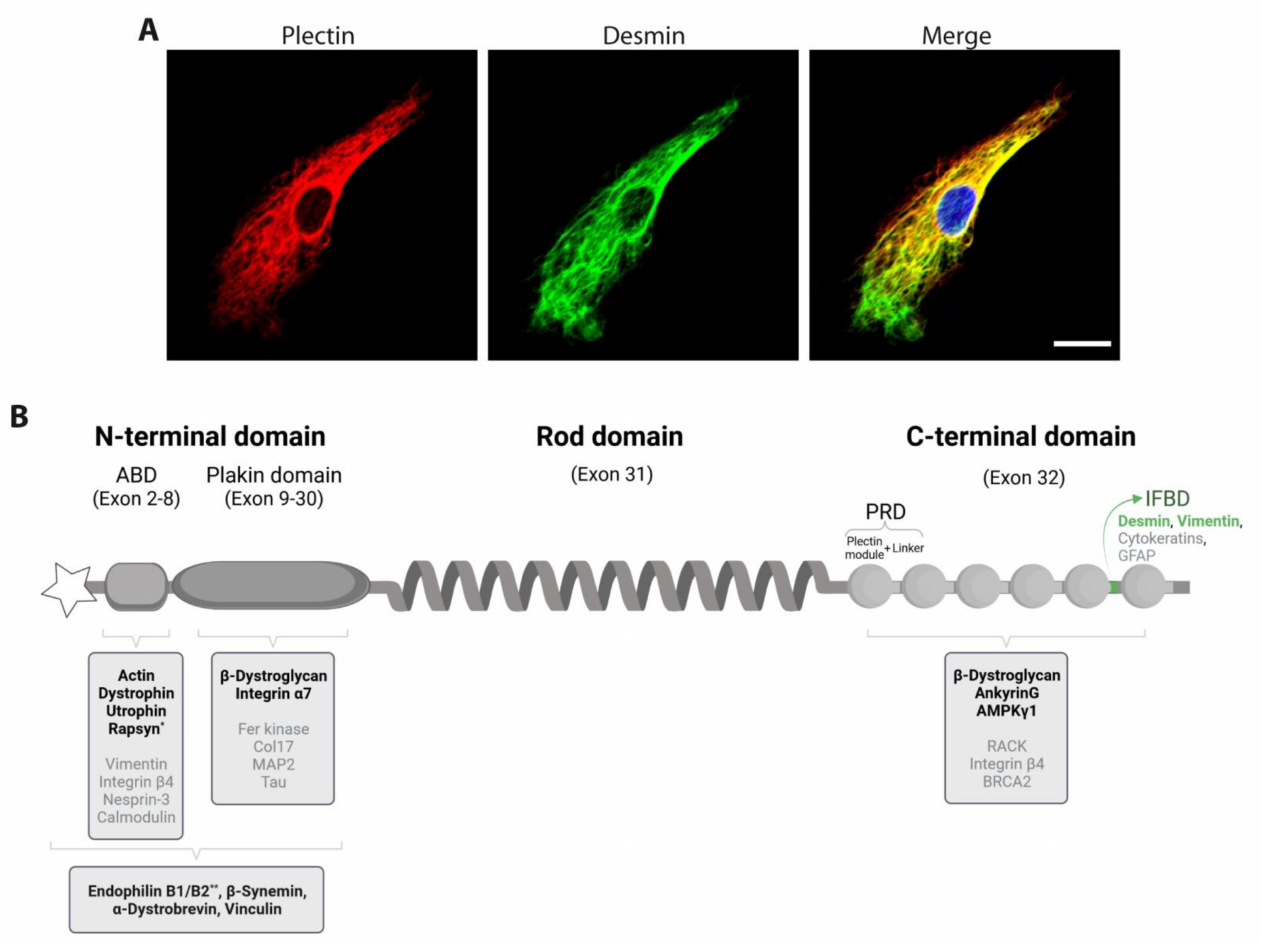
Figure 1. Subcellular localization of plectin in a myoblast and schematic representation of plectin and its binding partners, with a special focus on direct interaction partners identified in myoblasts and/or skeletal muscle. ( A ) Immunofluorescence microscopy of a human primary myoblast using antibodies to plectin (in red) and desmin (in green). The nucleus was visualized using DAPI (blue in the merged image). Note the co-localization of plectin and desmin. Scale bar: 15 µ m. ( B ) Schematic domain map of the protein. The tripartite structure of plectin comprises a central rod domain (encoded by exon 31) flanked by N- and C-terminal domains. The N terminus harbors differentially spliced first exons (star), an actin-binding domain (ABD, exons 2–8), and a plakin domain (exons 9–30), while the C terminus comprises six plectin repeat domains (PRD), each containing a conserved core (plectin module) and a linker region. An intermediate filament binding domain (IFBD) is located between modules 5 and 6 (green). Binding partners are indicated below the scheme; binding partners which were experimentally found in myoblasts/skeletal muscle are highlighted in bold. * Interaction was shown for isoform P1f. ** Interaction was shown for isoform